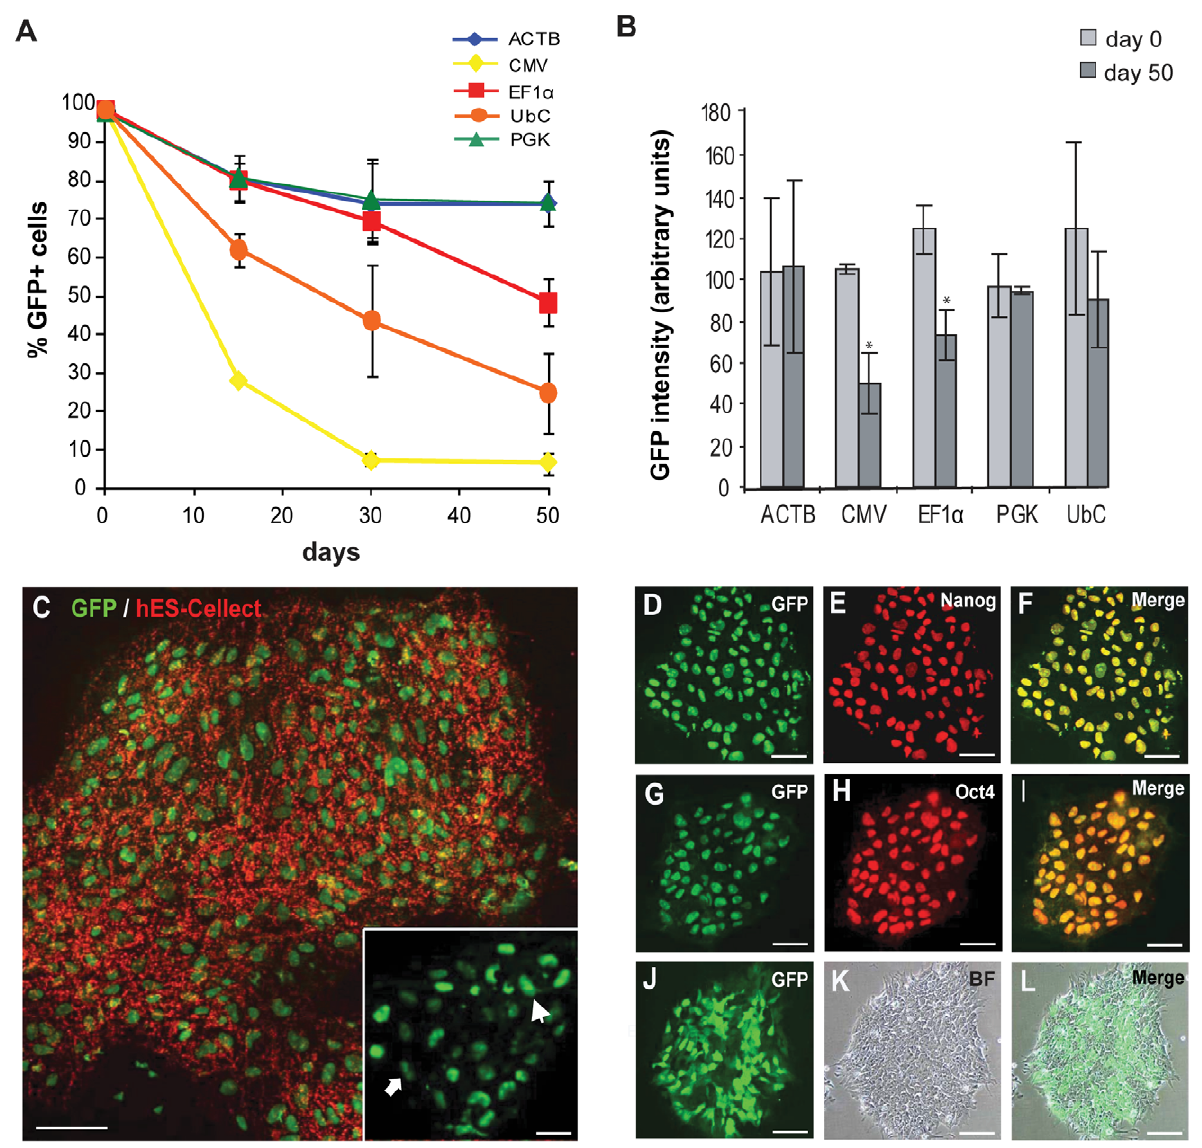
Figure 2. Constitutive promoter activity in long term culture of undifferentiated hESCs. The hESC line SA121 was transduced with lentiviral vectors containg the pTRIP-ACTB-, CMV-, EF1 a -, PGK-or UbC-eGFP lentiviral vectors. 10 days after transduction, eGFP + and eGFP 2 cells were separated by FACS sorting, referred to as day 0. Isolated eGFP + cells were thereafter cultured for 50 days under self-renewing conditions and promoter activities were measured by FACS analysis at day 0, 15, 30, and 50. A . Promoter activities as percentage of eGFP + cells at day 0, 15, 30 and 50. B . Intensity of fluorescent signal of eGFP expression from the same eGFP positive cells that were FACS analysed day 0 and 50. Intensity was measured by FACS analysis and EF1 a promoter showed a significant decrease in intensity of eGFP expression from day 0 to day 50 (*p , 0,014 students t’test). Decrease of ACTB-, CMV-, PGK- and UbC-eGFP intensity from day 0 to day 50 is not significant. A – C . Data are shown as mean of three independent experiments. Error bars represent standard deviation of the mean ( 6 s.d.). C – L . Immunofluorescence stainings of ACTB-eGFP + cells 30 days after FACS sorting. eGFP expressing cells show uniform expression of pluripotency markers; hES-Cellect ( C ), inset in C shows low and high intensity eGFP expressing cells, Nanog ( D – F ) and Oct3/4 (G – I ). L . Merged image of colony morphology of human ES cells cultured on Matrigel ( K ) and eGFP expression within the colony ( J ). Scale bar in C represent 100 m M, inset and D – L 200 m M. Cells representative of high eGFP expressing is indicated by arrowhead and low eGFP expression by